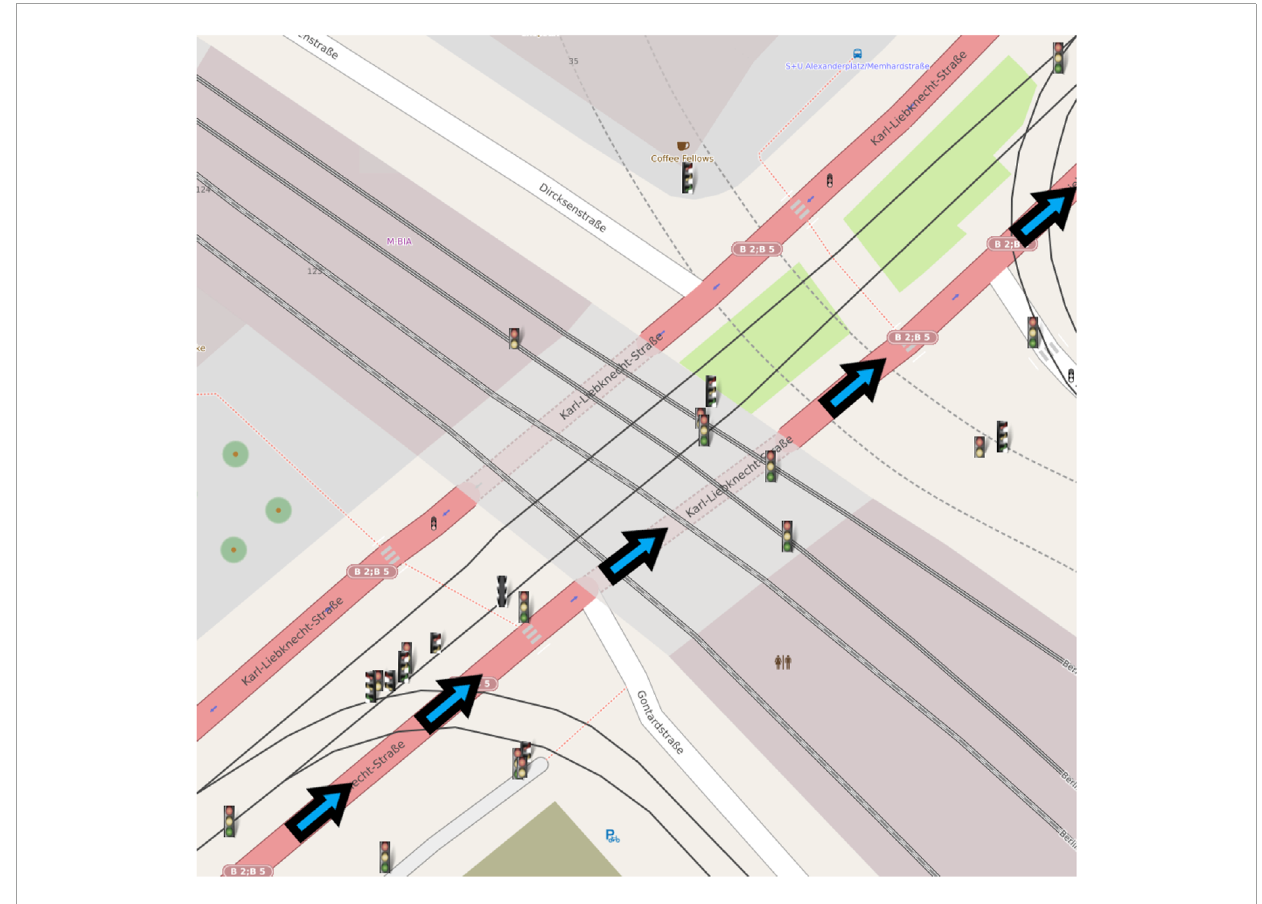
FIGURE 6 Second map with a lower resolution, obtained from a sequence of the DTLD test set.